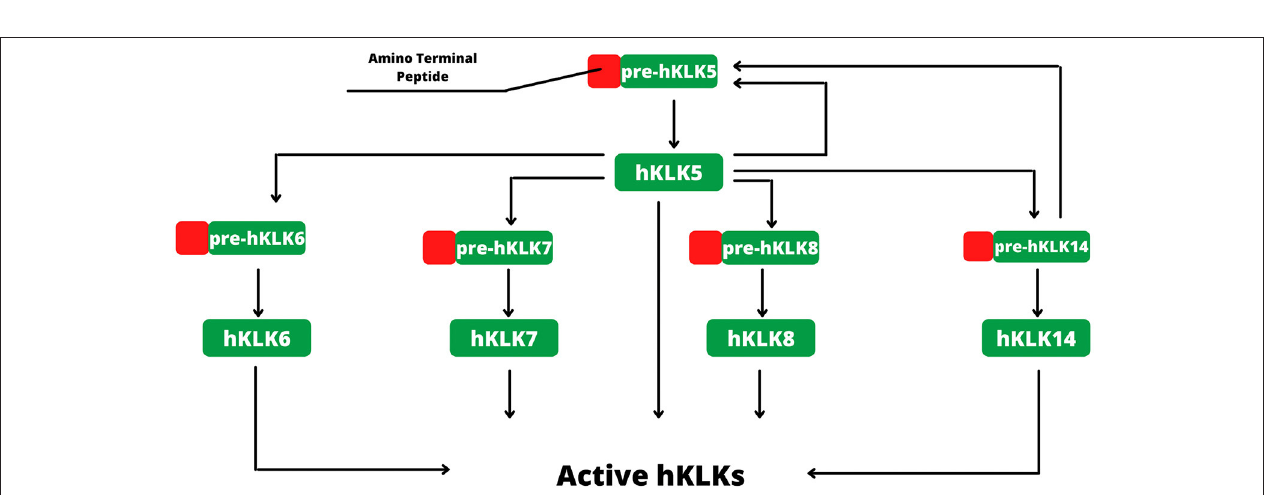
FIGURE 2 | Activation of hKLKs by proteolytic cascade. The activation starts with pre-hKLK5, which is capable of self-activation. Activated hKLK5 hydrolysis pre-hKLK6, pre-hKLK7, pre-hKLK8 and pre-hKLK14. Activated hKLK14 hydrolysis pre-hKLK5, amplifying the cascade. The proteolytic cascade of hKLKs activation is regulated by endogenous inhibitors, such as LEKTI, pH, and